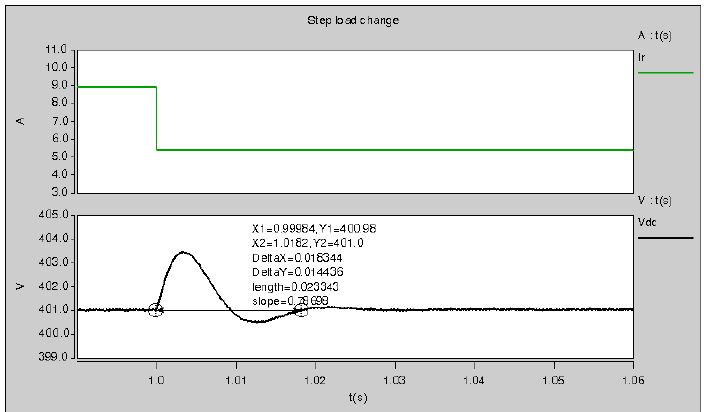
Figure 15. Parameter variation for the robustness analysis.